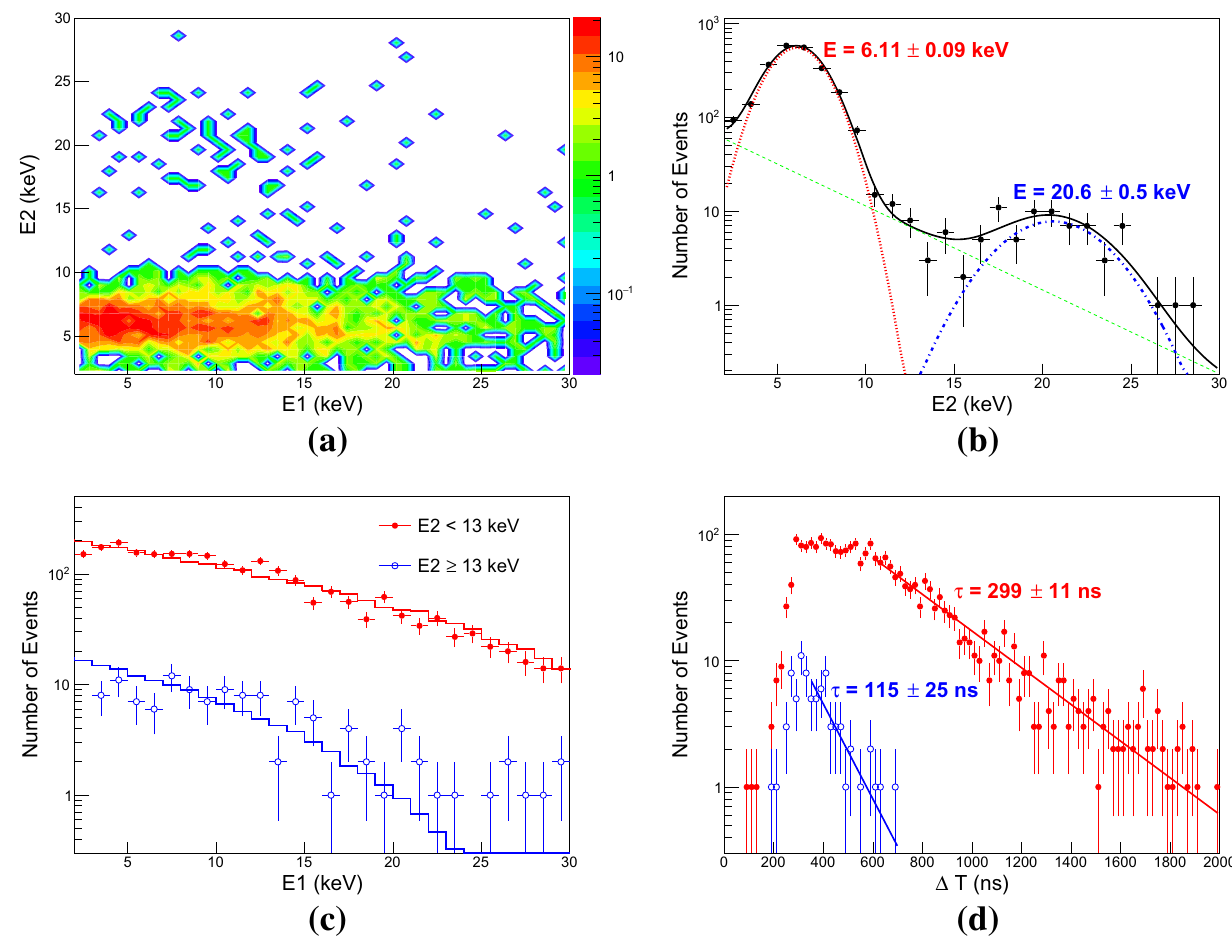
Fig. 5 ( a ) A scatter plot of energy of the second pulse versus the first pulse (E2 vs E1). ( b ) The E2 spectrum (points) is modeled with two Gaussians (dotted and dotted-dashed lines) and an exponential back- ground contribution (dashed line). ( c ) The E1 spectra for E2 < 13keV (filled circles) and E2 ≥ 13keV (opened circles) are compared with a